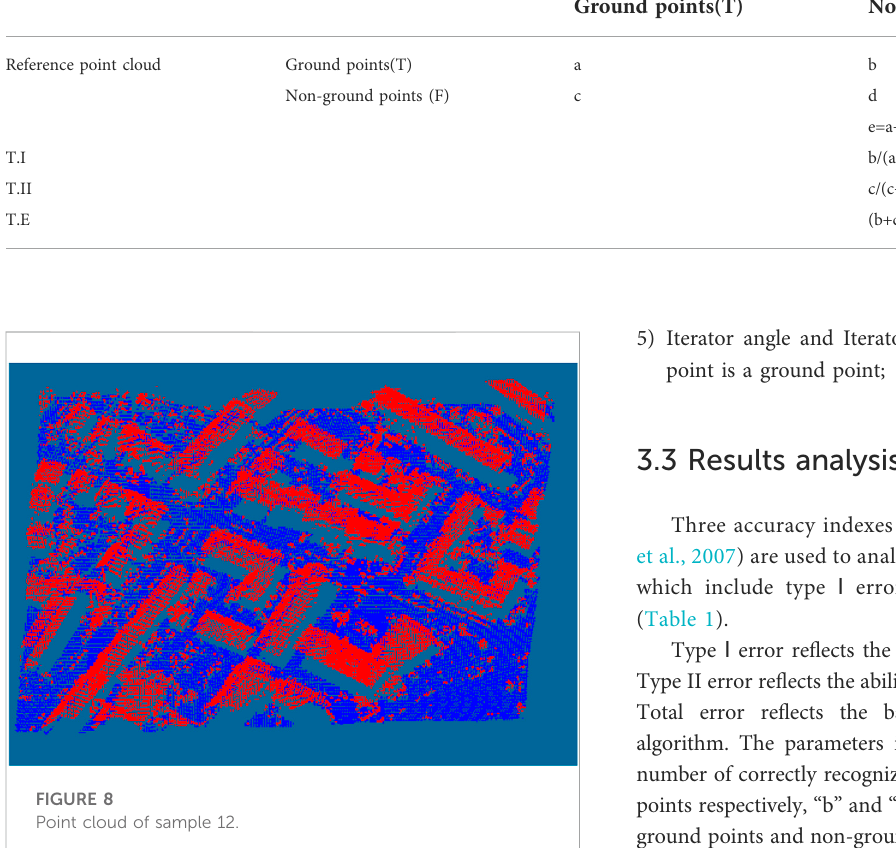
FIGURE 8 Point cloud of sample